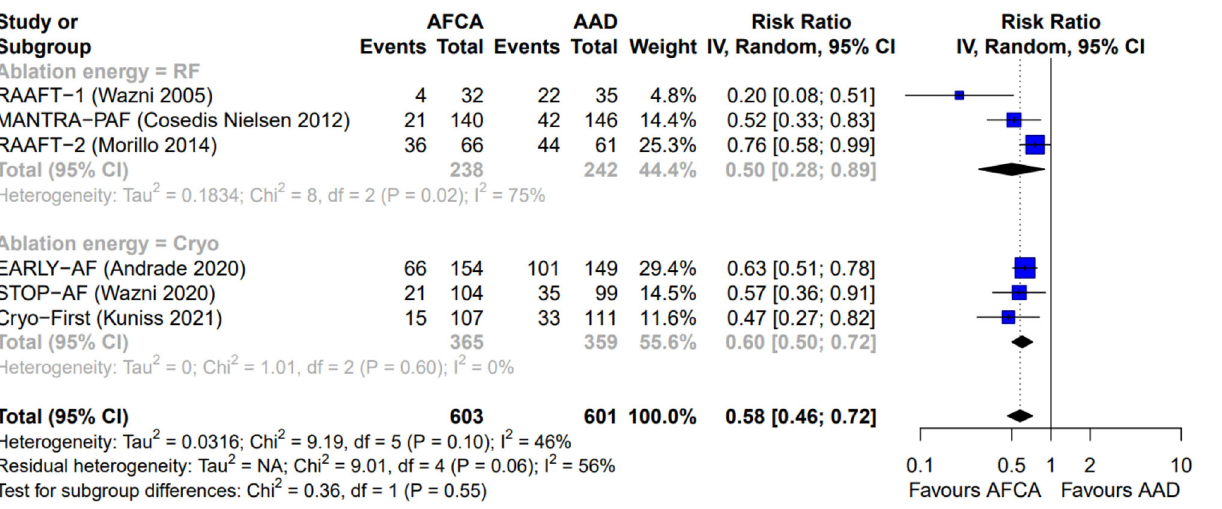
FIGURE 2 | Forest plot reporting the risk of recurrence of atrial tachyarrhythmias, stratified by ablation energy (radiofrequency or cryoenergy).